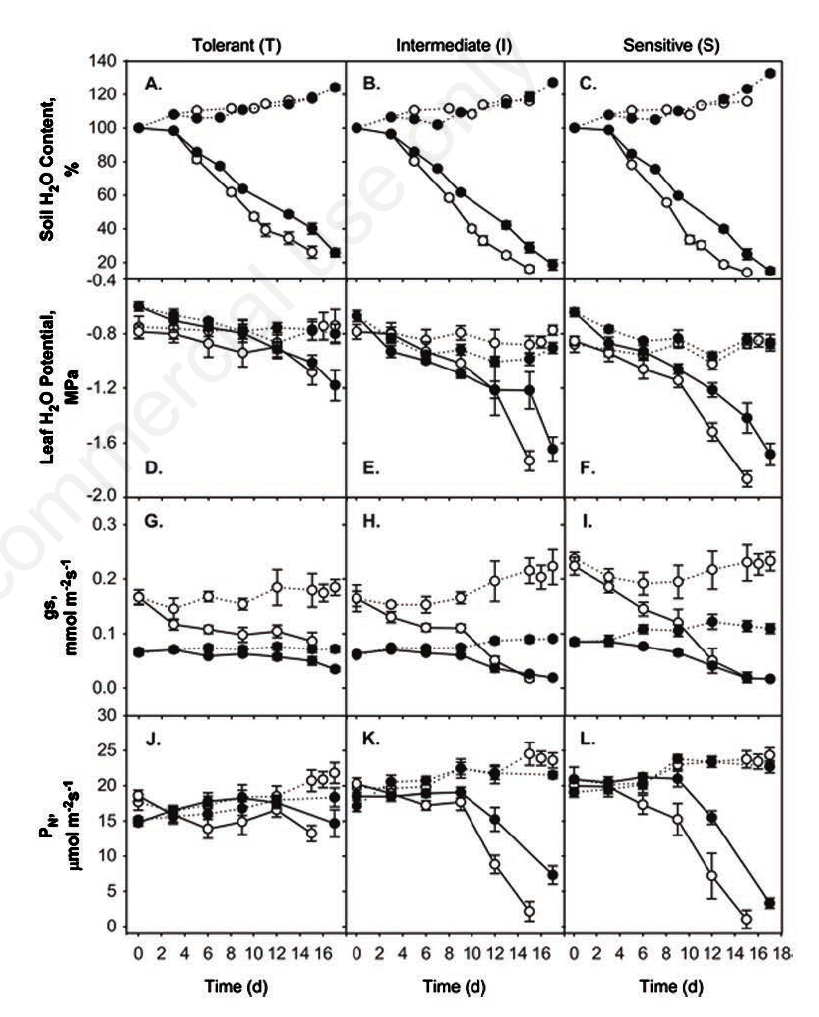
Figure 2. Genotypic differences of water relations and of single leaf gas exchange among three maize hybrids differing in susceptibility to drought. Changes of net photosynthesis ( mol m –2 s –1 ; A-C), stomatal conductance (mmol m-2s-1; D-F), leaf water potential (MPa, G-I) and soil water content (%: J-L) in response to drought are shown for the inter- μ mediate (A,D,G,J), tolerant (B,E,H,K) and sensitive (C,F,I,L) maize hybrids. Results are shown for water sufficient (dotted line), water insufficient (solid line) ambient ( elevated ( ) CO treatments. Values are means ± standard error for eight samples from 2 two fully replicated ●